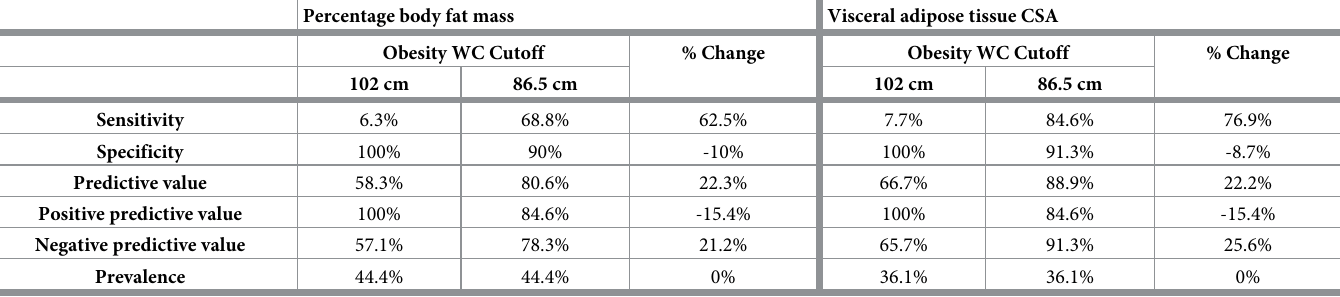
Table 3. Comparison of sensitivity, specificity, predictive and prevalence values for comparison of obesity using WC cutoff values (102 cm vs 86.cm) with respect to percentage body fat mass and visceral adipose tissue CSA.